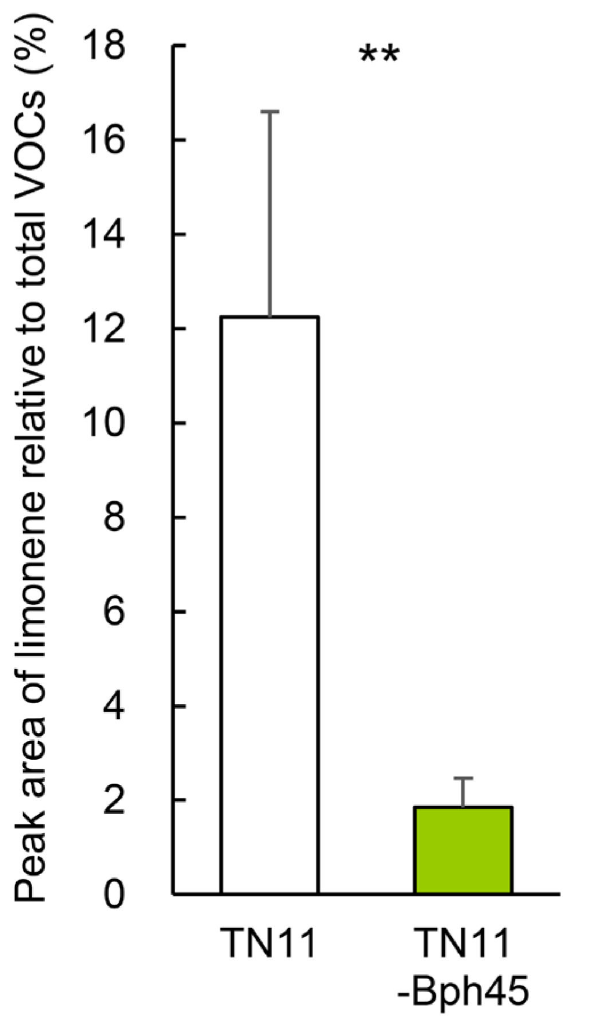
Figure 7. Limonene amounts in TN11 and TN11- Bph45 . Same as in Figure 3. Statistical analysis was performed using Student’s unpaired t -test (N = 4). ** p <